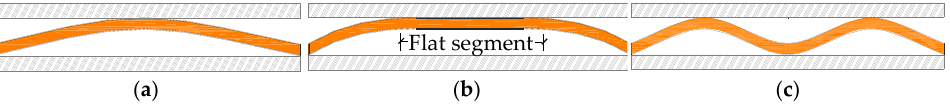
Figure 2. Buckling development of flat plate core of BRB. ( a ) One point contact. ( b ) Development of flat segment. ( c ) Higher buckling mode.